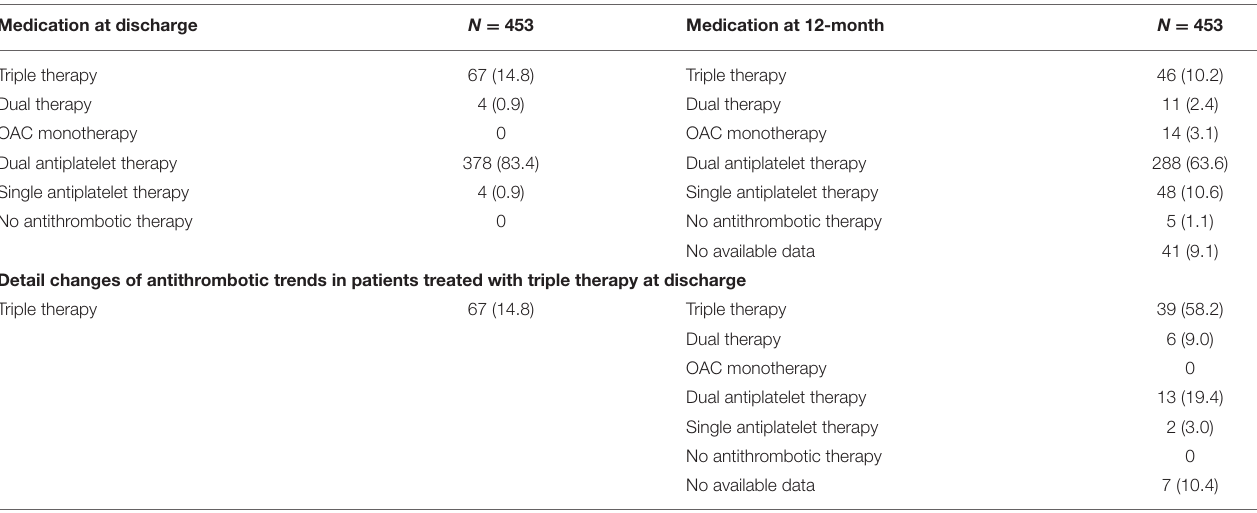
TABLE 3 | Changes of antithrombotic trends between discharge and 12-month follow-up visit. Medication at